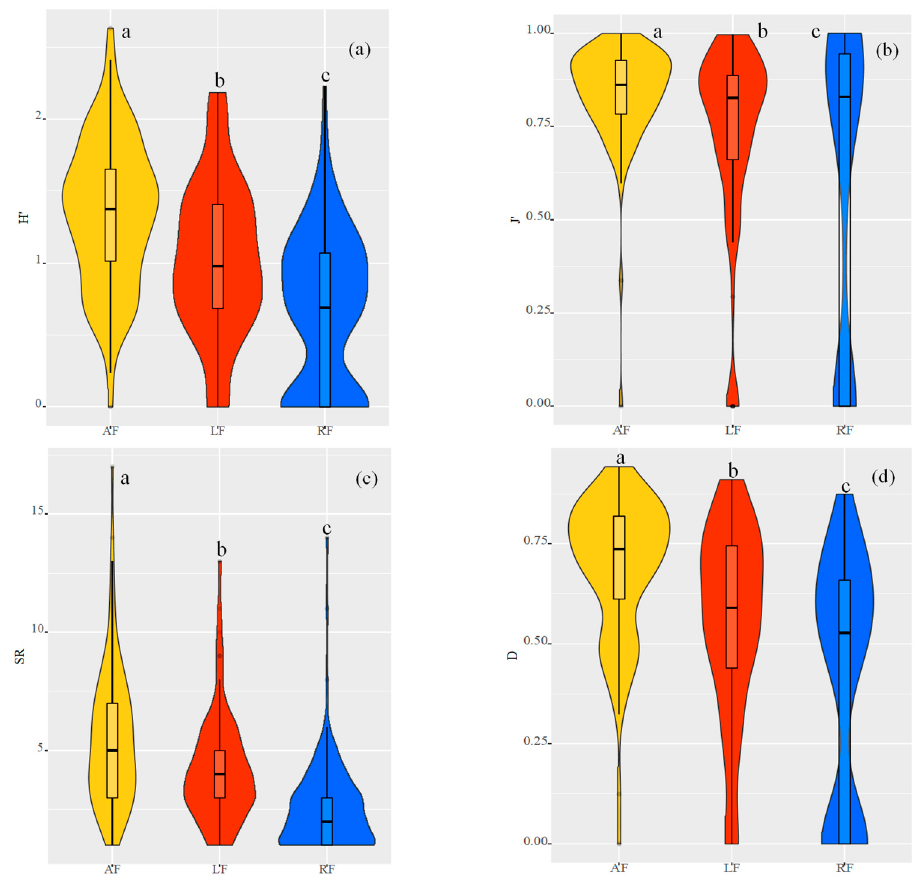
Figure 3. The distribution of species diversity indexes. ( a ) depicts the distribution of Shannon–Wie- ner index (H’); ( b ) depicts the distribution of evenness index (J’); ( c ) depicts the distribution of spe- cies richness (SR); ( d ) depicts the distribution of Margalef index (D). In the figure, mean values shar- ing different letters are significantly different ( p < 0.05), and mean values sharing the same letters are not significantly different ( p > 0.05). RF, road forest; AF, attached forest; LF, landscape and re- laxation forest.